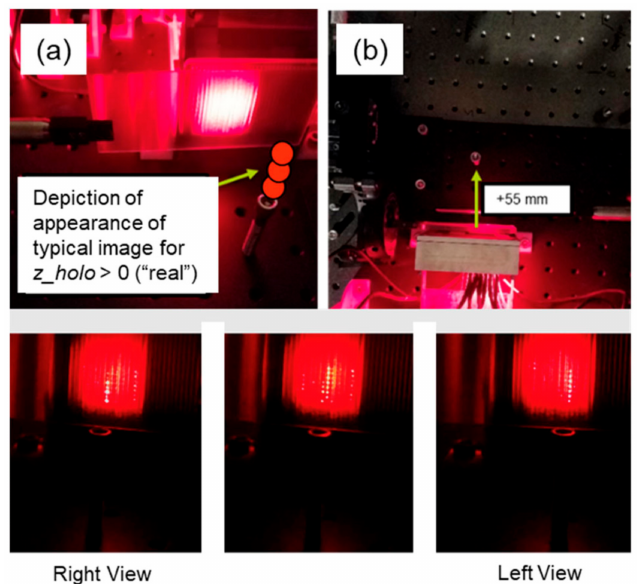
Figure 20. ( a ) The demonstration edge-emitting array 3D display was used to create test imagery composed of a single vertical line segment at a horizontal and depth location as entered by the user. Rays converge above the location of a physical reference point—a screw head. ( b ) Top view. (bottom) Appearance of the holographic scene from three horizontally different viewpoints, in which the image location remains above a screw head used as a physical reference object; the image appears fixed with respect to the viewer. Reproduced with permission from